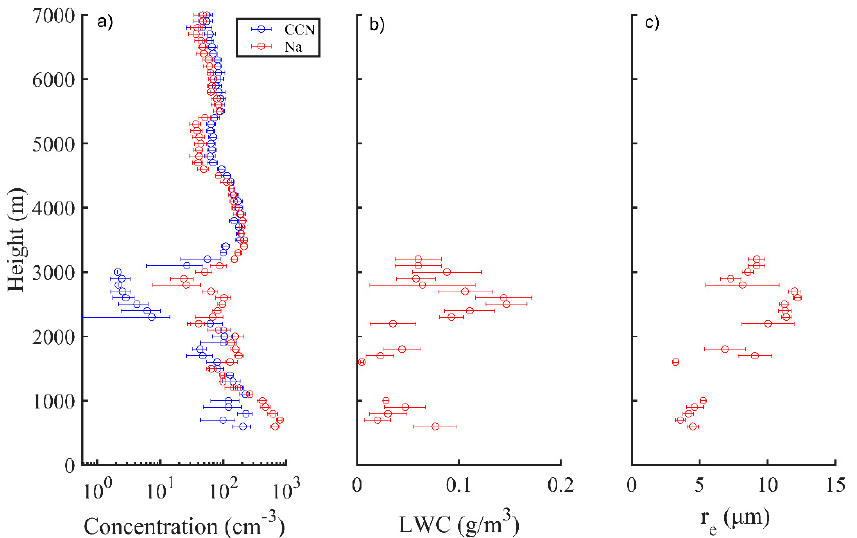
Figure 3. Vertical distribution of ( a ) aerosol number concentration (Na) with sizes between 0.1 and 10 μ m (red squares) measured by PCASP, and cloud condensation nuclei (CCN) at a supersaturation of 0.3% (blue squares) measured by the CCN counter, ( b ) liquid water content (LWC), and ( c ) cloud droplet effective radius (r e ), over Huanghua, China on 26 April 2014. The circles and bars represent the means and standard deviations of the examined variables at each bin of altitude.